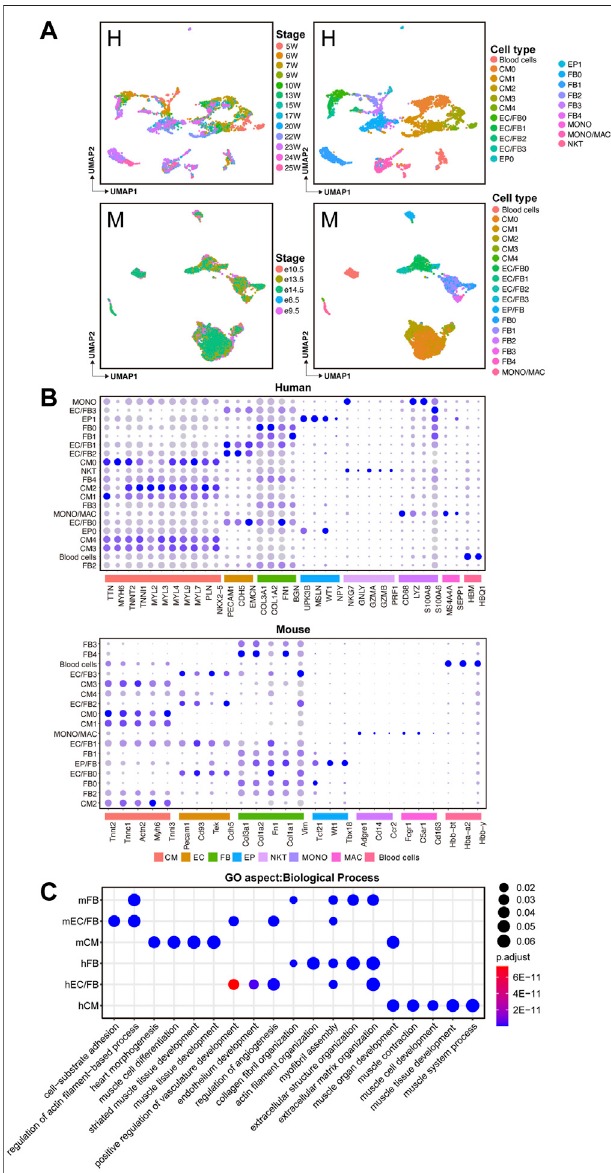
FIGURE 1 | Identi fi cation of major cell types in human and mouse fetal hearts. (A) UMAP plots showing the developmental stages (left) and cell clusters (right) of human (H, upper) and mouse (M, lower) fetal heart development. (B) Bubble plots showing the expression levels of known marker genes for each cell population. (C) GO enrichment analysis of differentially expressed genes between human and mouse cell